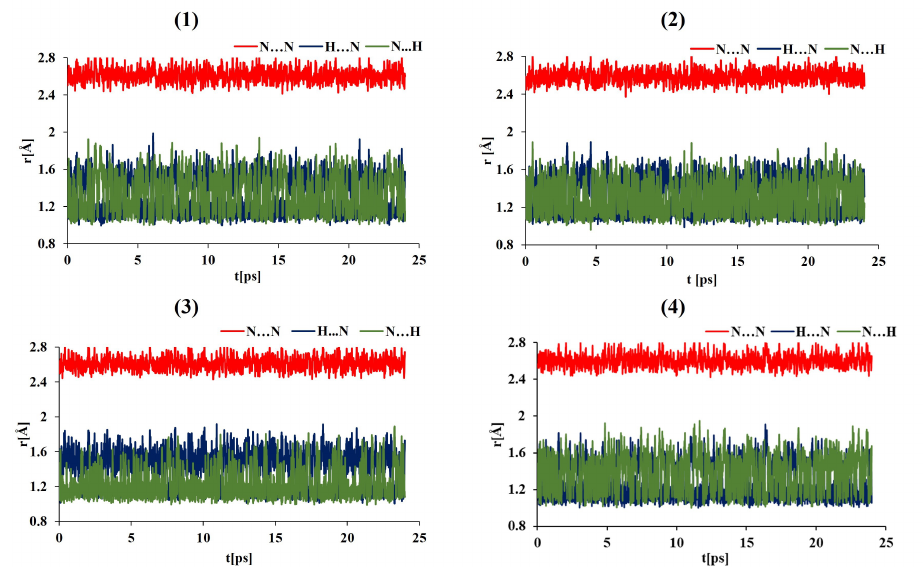
Figure 5. Time evolution of the intramolecular hydrogen bond metric parameters. Gas phase CPMD results at 300 K for DMANH + and its